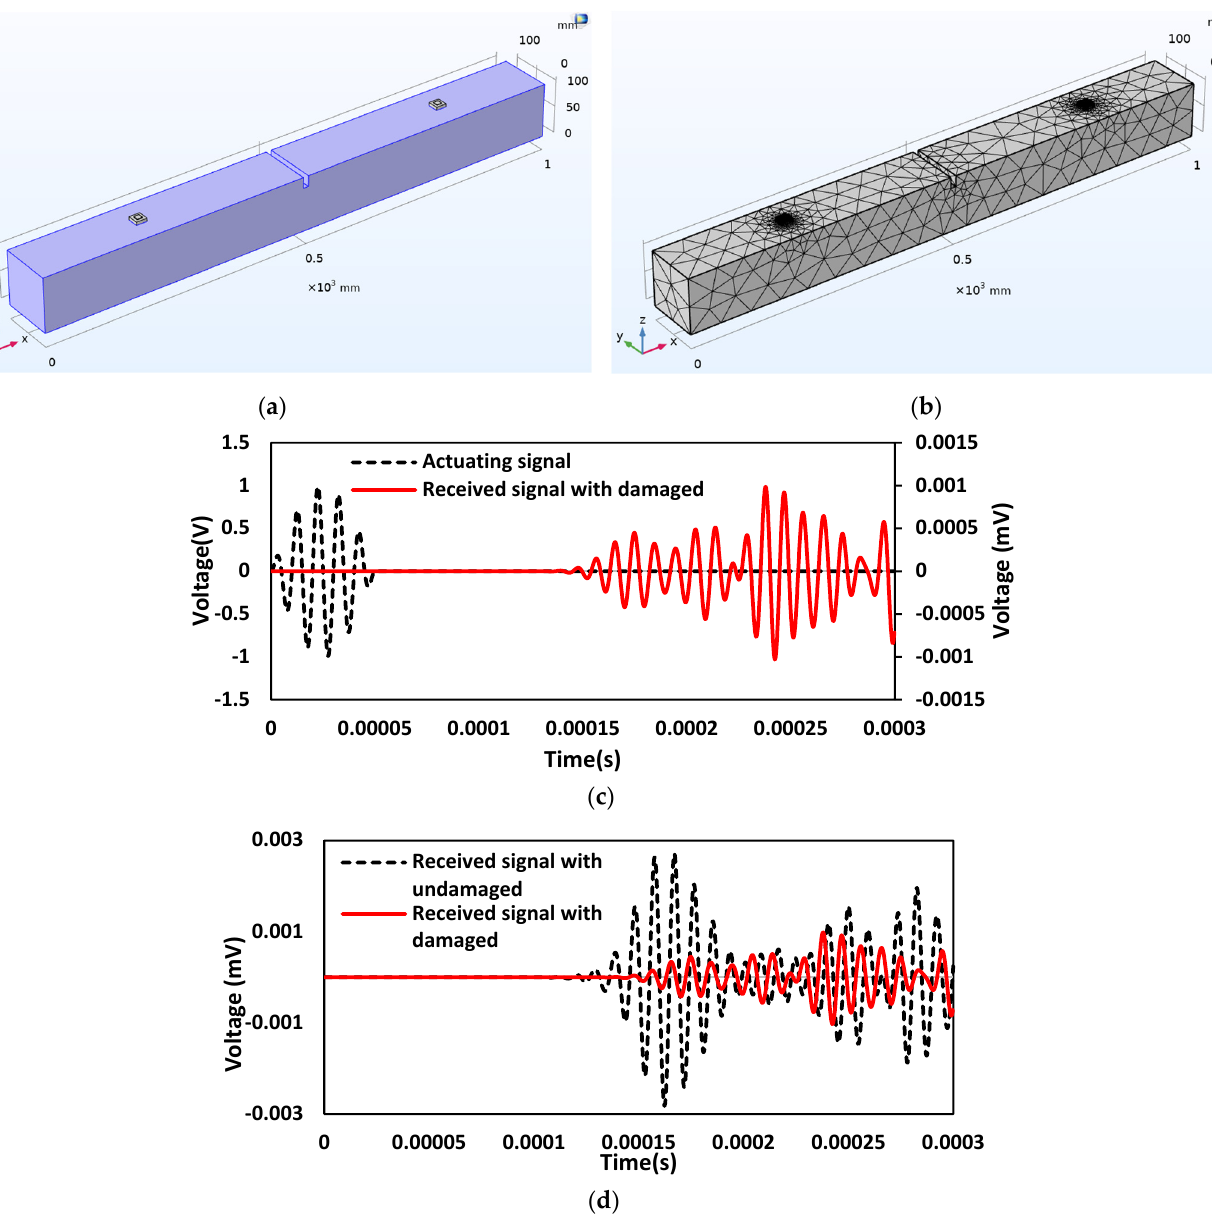
Figure 16. Damaged concrete beam with surface mounted SSUs: ( a ) Schematic 3D model; ( b ) FE model; ( c ) Response spectrum obtained from wave propagation measurements in the actuator–receiver mode; ( d ) Comparison of received signal between the damaged and no damaged concrete beam with the applied actuation signal.